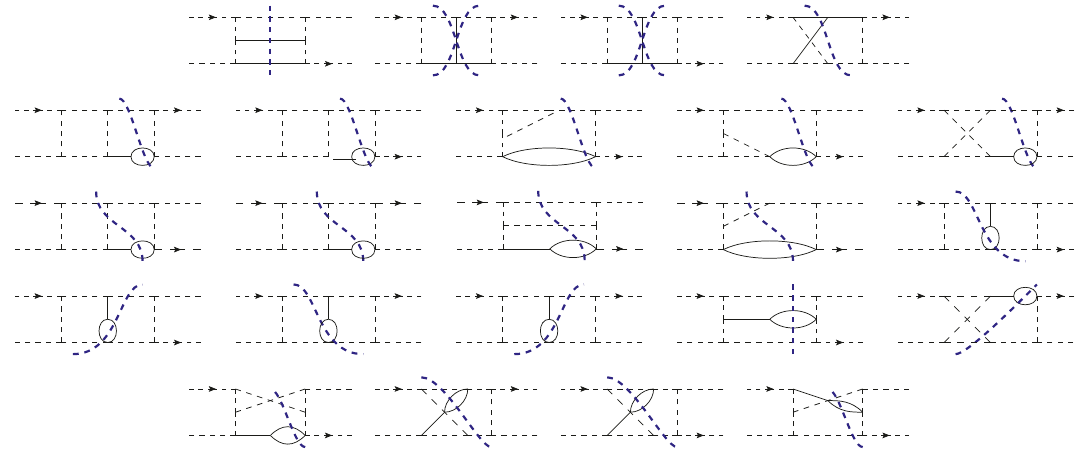
Figure 7 . Minimal set of integral families, obtained by LIMIT , for the two-loop (first line), three-loop real-virtual (second line) and three-loop real-real (third to fifth lines) phase-space contributions. The arrow on external lines denotes the momentum q and the blue dashed lines represent the 1